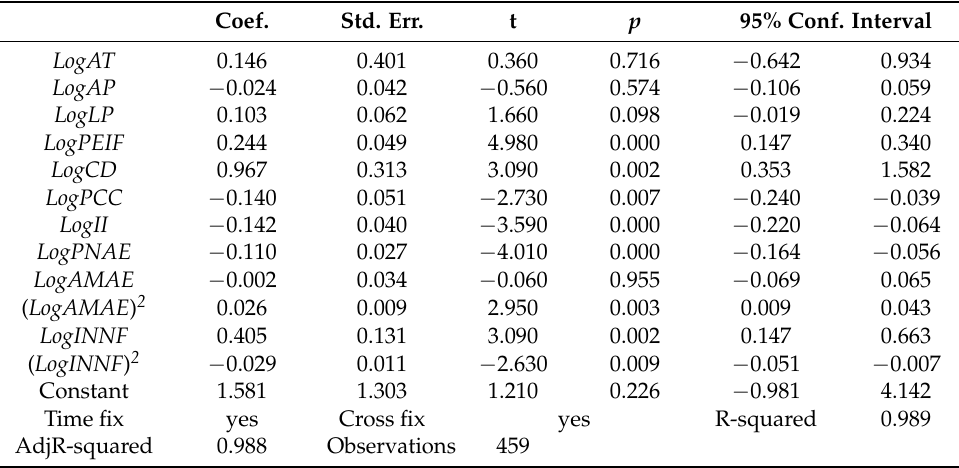
Table 3. Results of the estimations and tests of the models. Coef. Std.